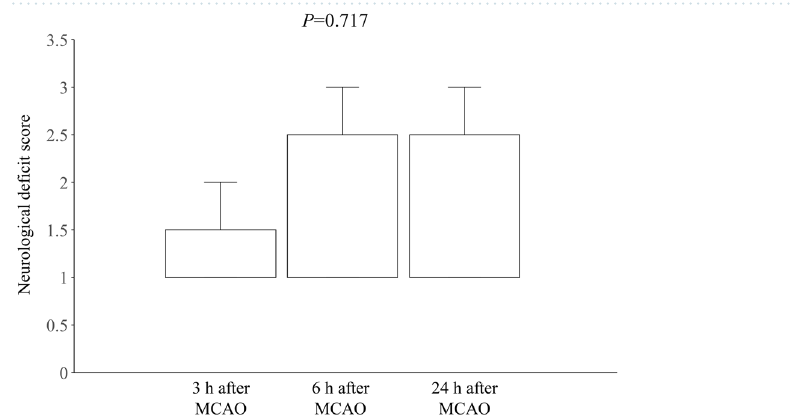
Figure 5. MRI 24 h after the creation of the zirconia MCA occlusion model. The zirconia ball did not affect the MRI. ( A ) MR angiography detected the impaired blood flow in the left MCA. ( B ) T2-weighted MRI showed infarction only in the MCA perfusion area, but not in the AchA and HTA. AChA anterior choroidal artery, HTA hypothalamic artery, MCA middle cerebral artery, MRI magnetic resonance imaging.